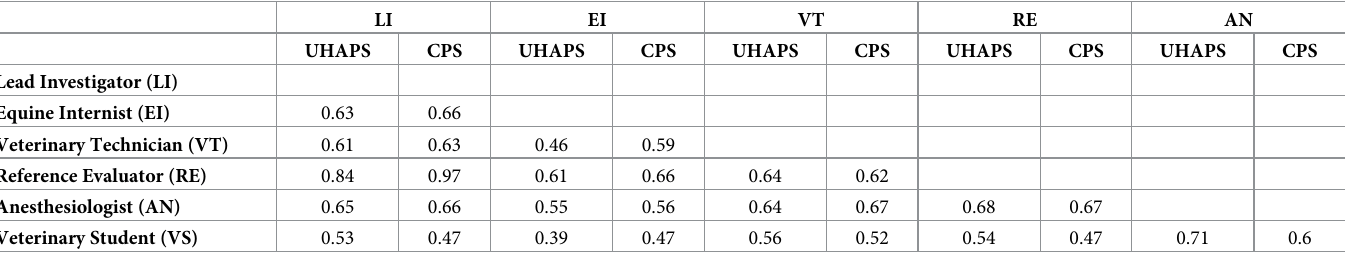
Table 3. Observer matrix correlation for the Unesp-Botucatu horse acute pain scale (UHAPS) and the Composite Pain Scale (CPS) to assess perioperative pain in horses.